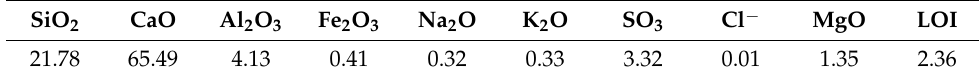
Table 1. Chemical composition of the used cement.